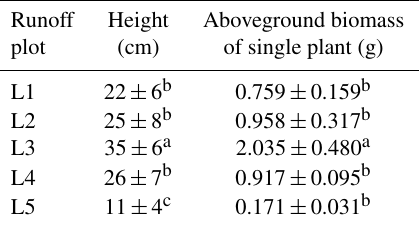
Table 3. Height and single plant biomass R. pseudoacacia . Runoff Height Aboveground biomass plot (cm) of single plant